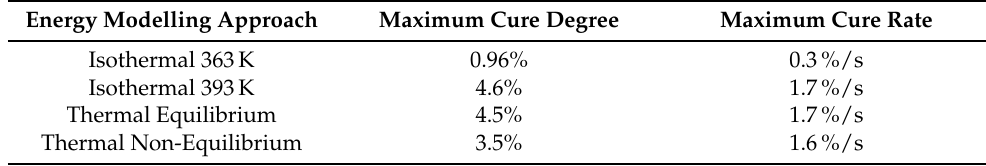
Table 5. Minimum and maximum cure degree values in the domain after infiltration for each energy modelling